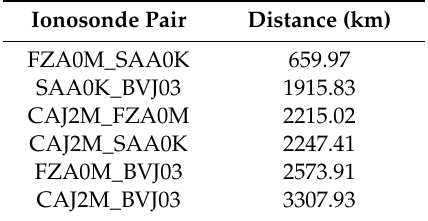
Table 2. Six possible pair combinations of the four ionosondes and their respective distances.